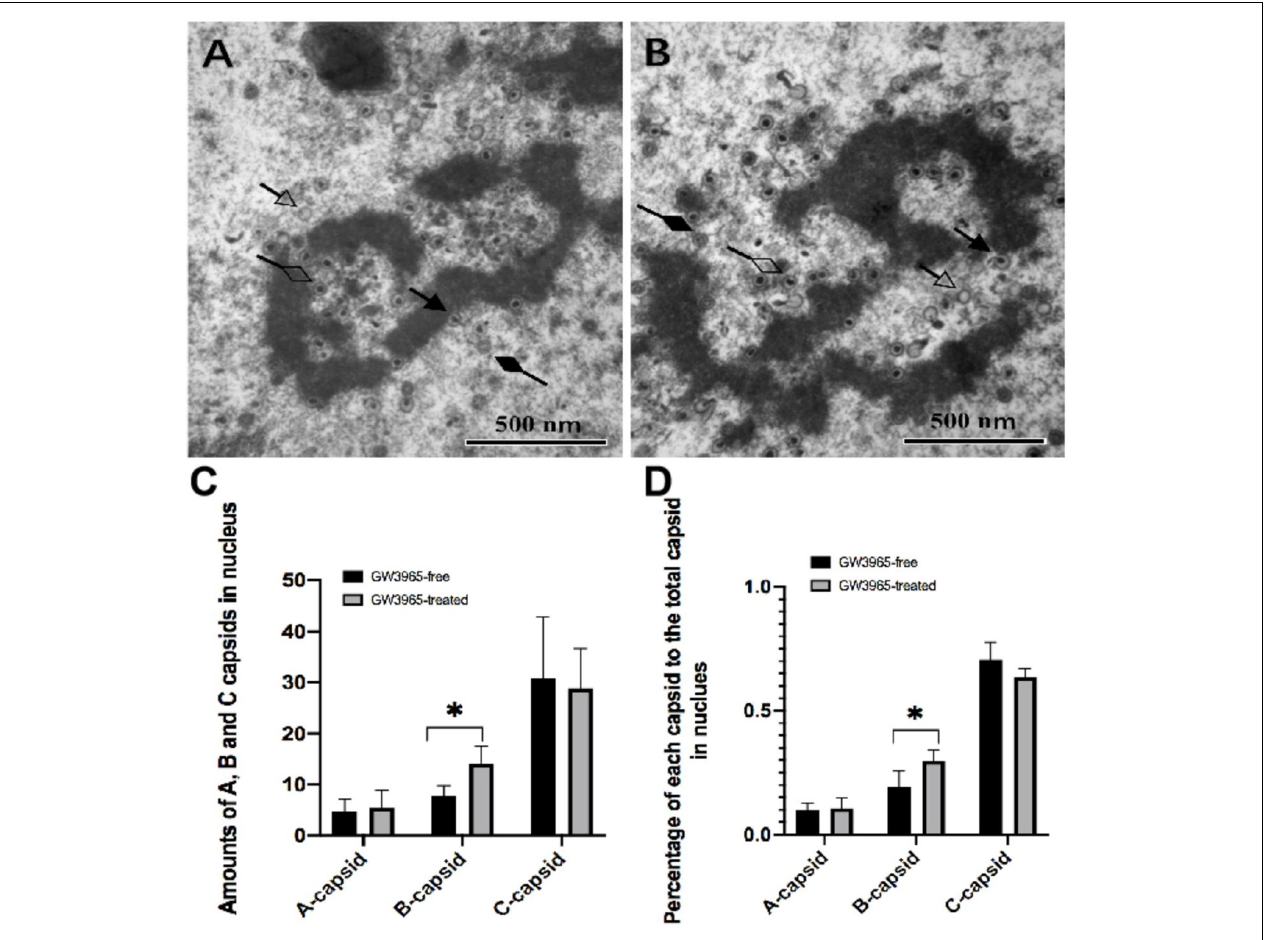
FIGURE 4 | Numbers of the three kinds of capsids in the nucleus of cells treated with and without GW3965. (A,B) The solid arrow points to the capsid undergoing DNA encapsidation. The capsids pointed by a hollow arrow, solid diamond-head arrow, and hollow diamond-head arrow are A-capsids, B-capsids, and C-capsids, respectively, at a magnification of 40,000. The numbers and the percentages of each kind of capsid in the nucleus of cells treated with and without GW3965 are presented in panels (C,D) , respectively * P <